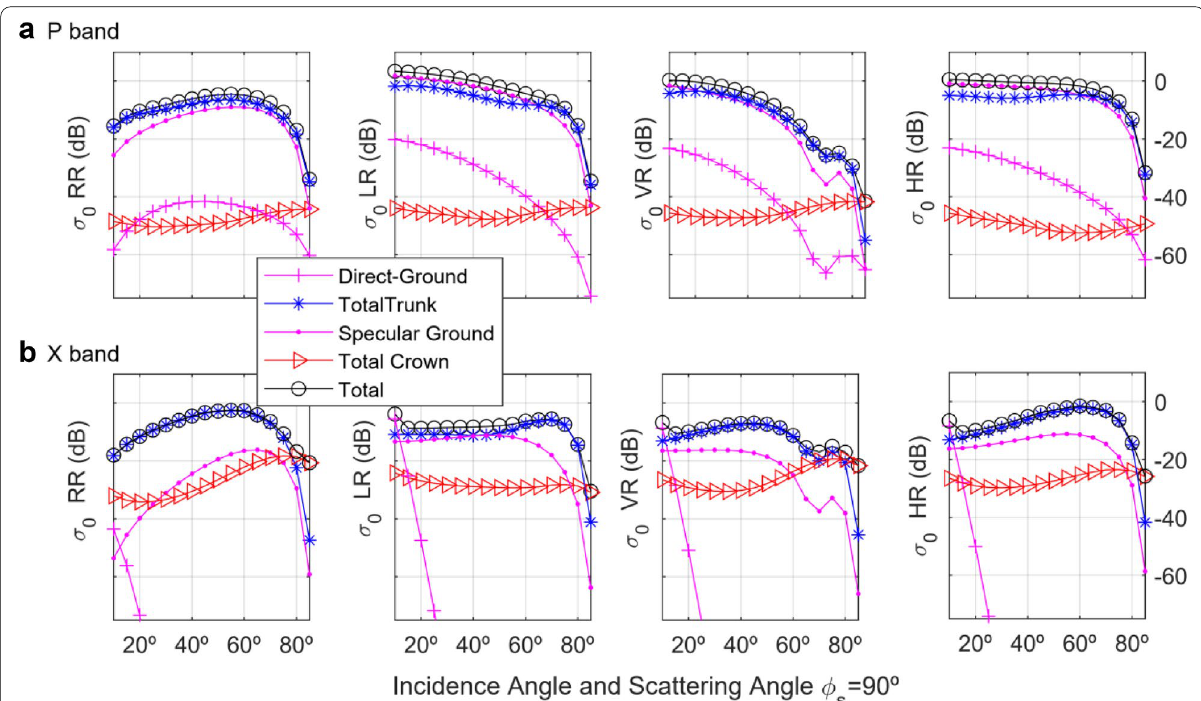
Fig. 8 P-band ( a ) and L-band ( b ) canopy scattering component contributions versus scattering angle from aspen at perpendicular scattering plane, ϕ s 90° for various polarizations =